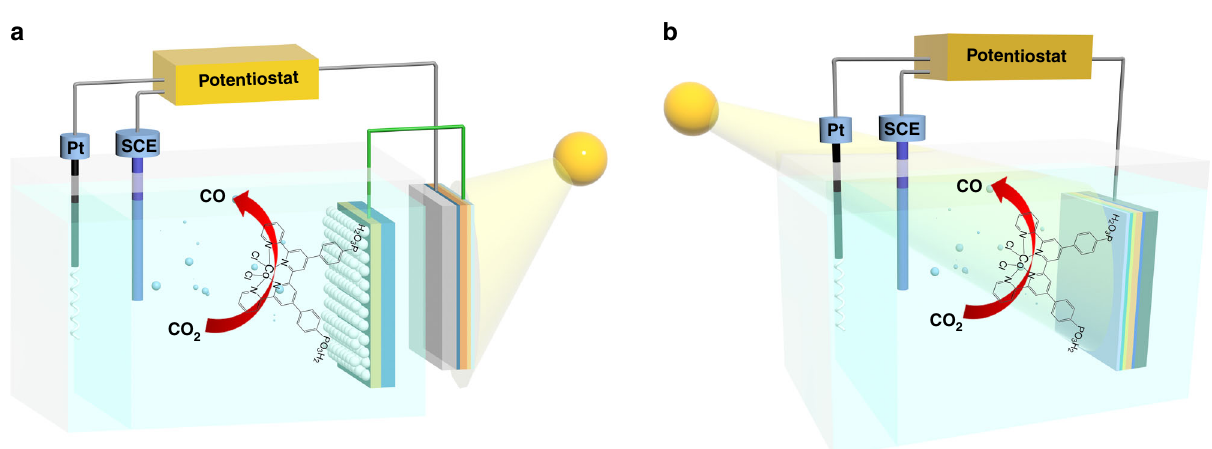
Fig. 5 Illustrative schemes of the photo-assisted cell systems investigated in this study. PV – EC system ( a ) and PEC system ( b